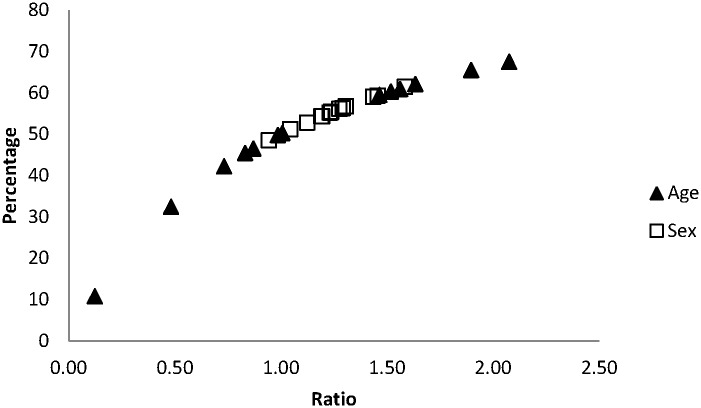
Percentage of juveniles and males in the age and sex ratios in the studied red-legged partridge population.